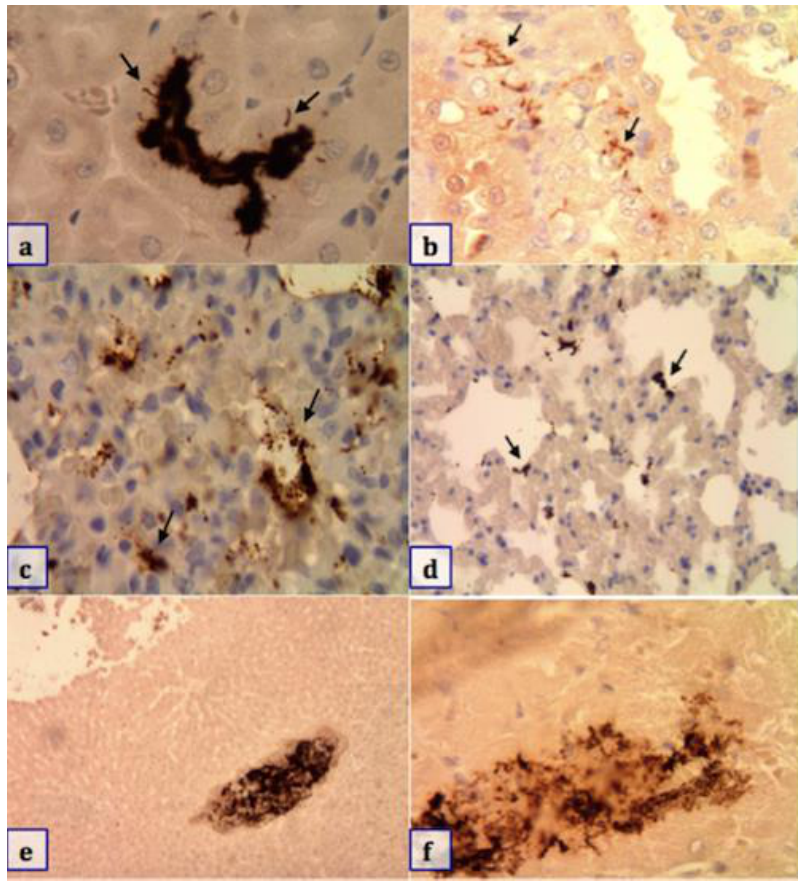
Figure 3. Indirect immunostaining (Anti-LipL32) of pathogenic Leptospira spp. Brown-stained aggregates of filamentous bacteria consistent with Leptospira (pointed out with arrows) in different tissues. ( a , b ) Tubular lumen and between cells of the tubular epithelium in the kidney (100×); ( c , d ) lung tissue (10×); ( e ) liver tissue (10×); ( f ) heart tissue (100×).